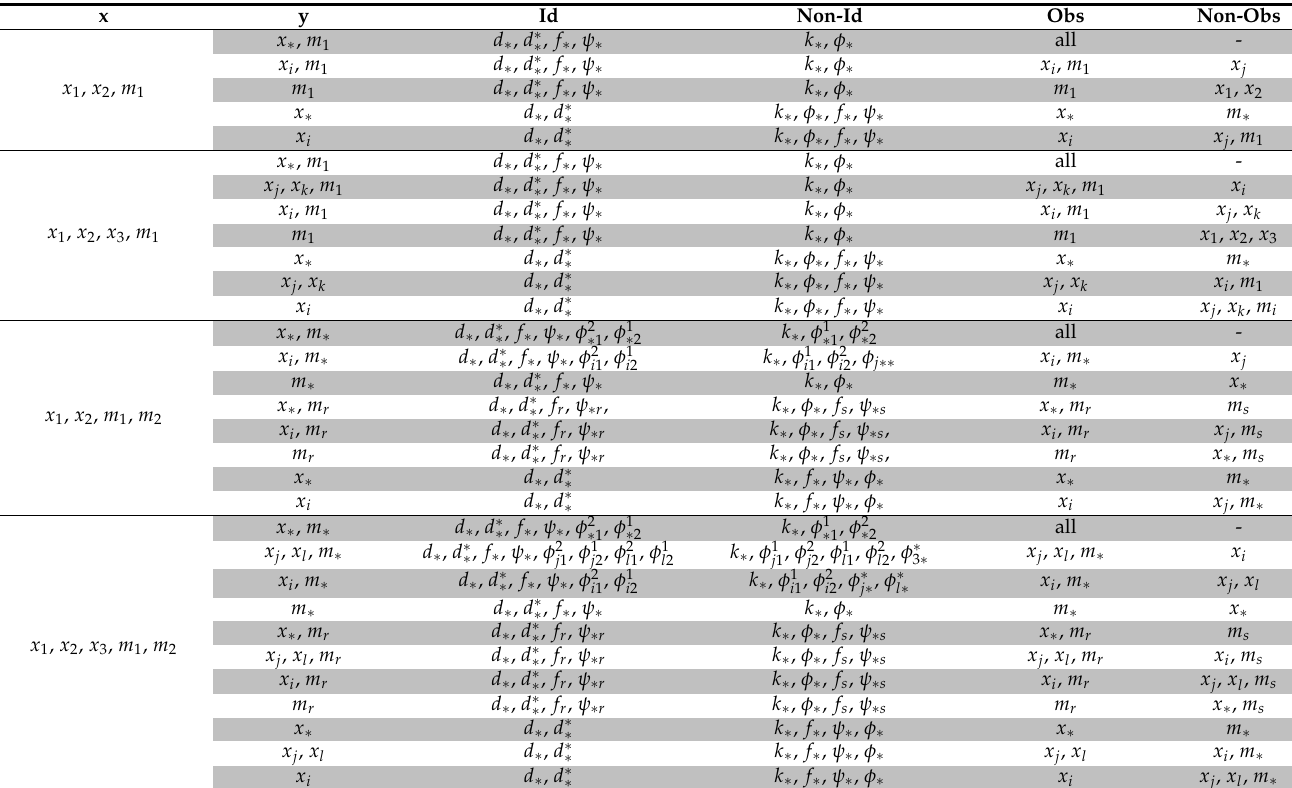
Table 3. QSMI. Results for the quadratic species–metabolite interaction models.